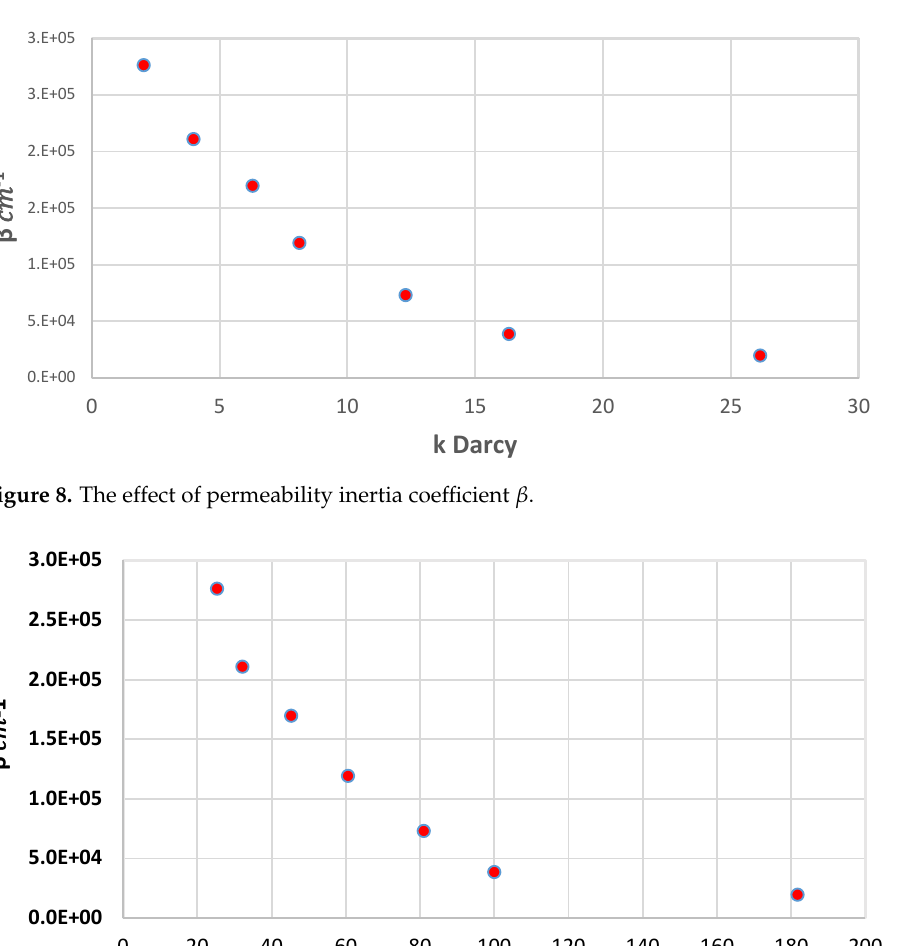
Figure 9. The effect of Median pore diameter on inertia coefficient β . Figure 10 shows the non-Darcy coefficient versus the tortuosity of the samples. The graphs indicate that the non-Darcy coefficient is directly proportional to the tortuosity. The non-Darcy coefficient increases with the increase in tortuosity.